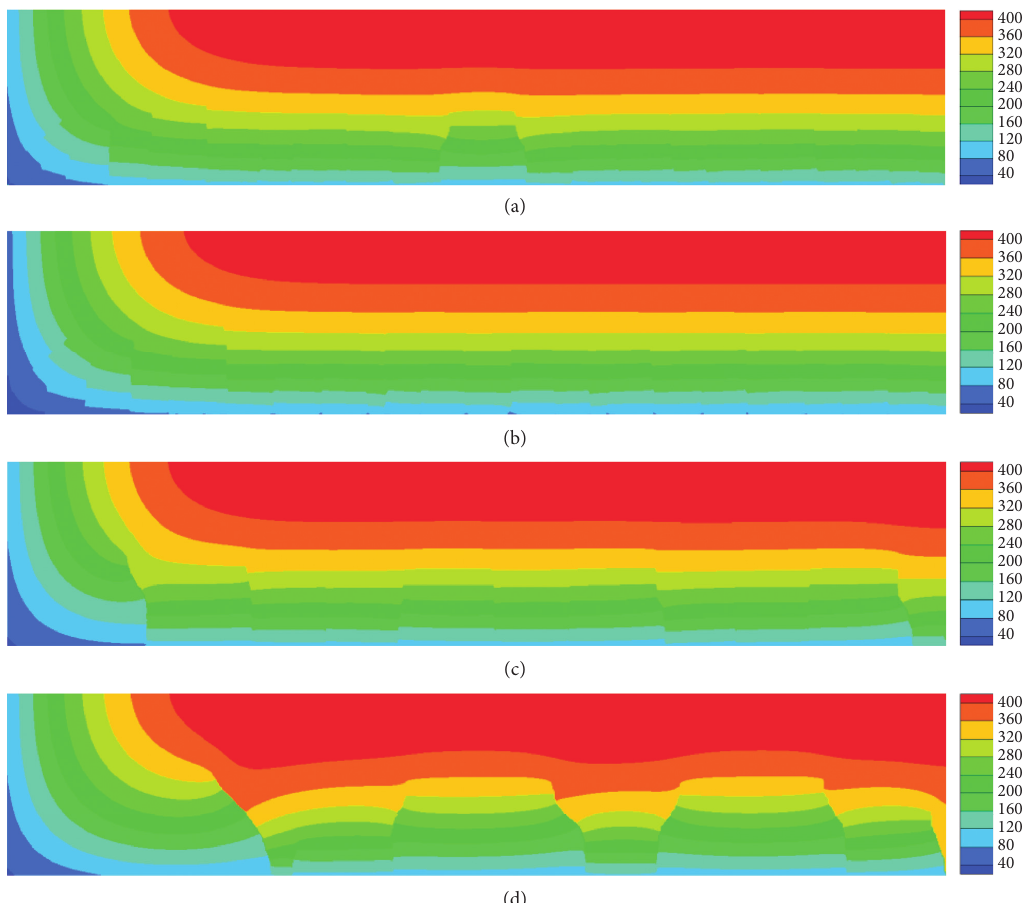
Figure 19: Temperature fields with a different ceramic fracture toughness ( t � 1.0 s): (a) K